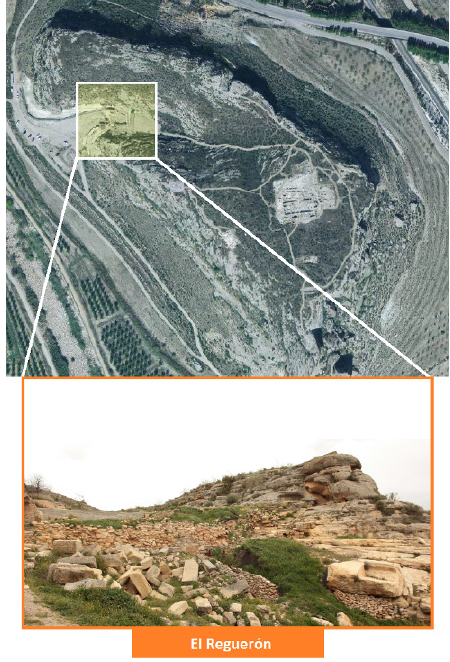
Figure 6. Location of the defensive area “El Reguerón”.